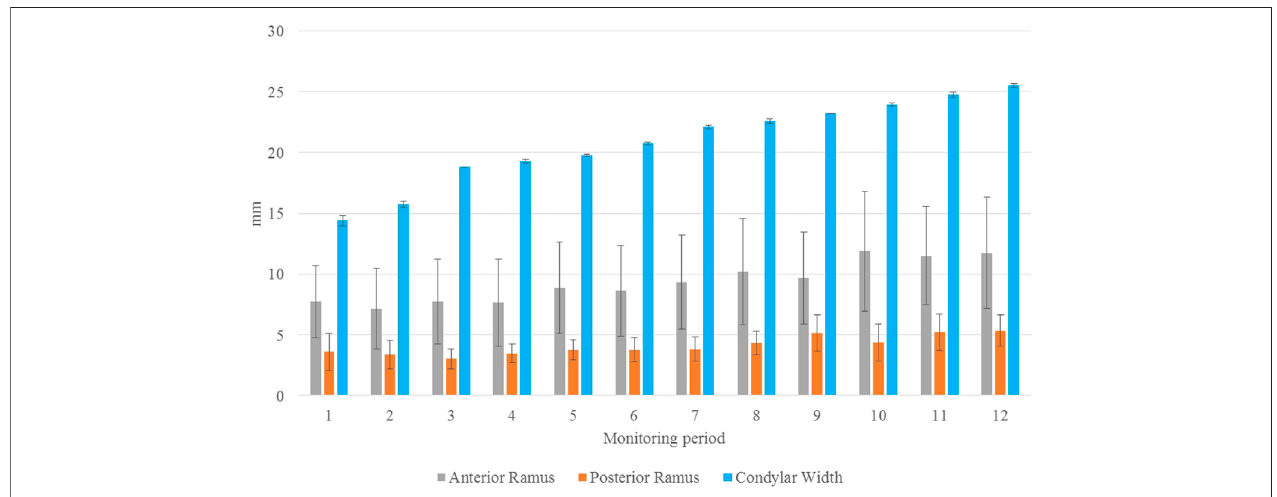
FIGURE 4 | Mean thickness of the anterior (gray) and posterior (orange) ramus regions and the mediolateral length of the condylar head (blue) over the monitoring period of one year from T1 to T12. Standard deviations are indicated as error bars. ( n = 8; unit: